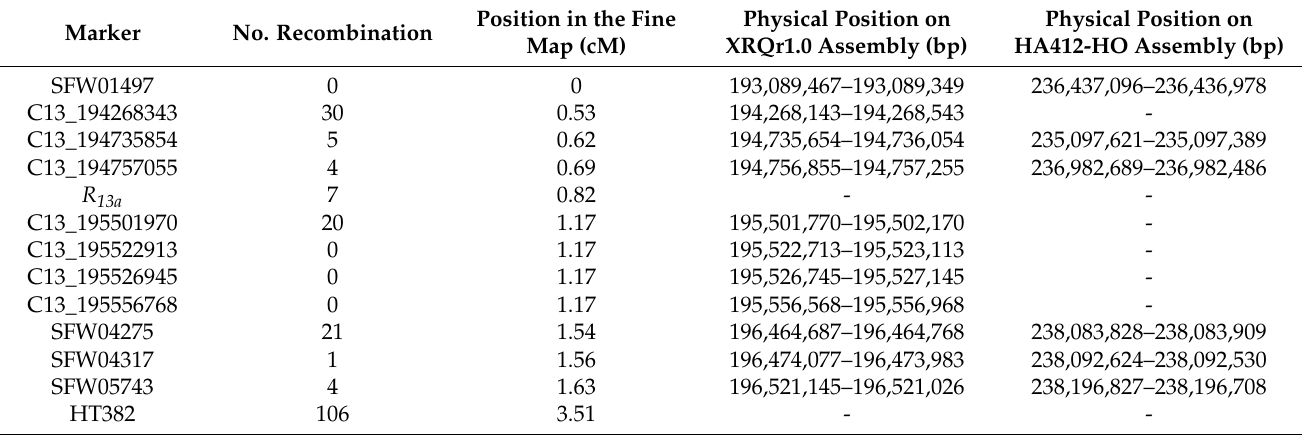
Table 1. Genetic and physical positions of the SNP markers linked to R 13a on a fine map of sunflower chromosome